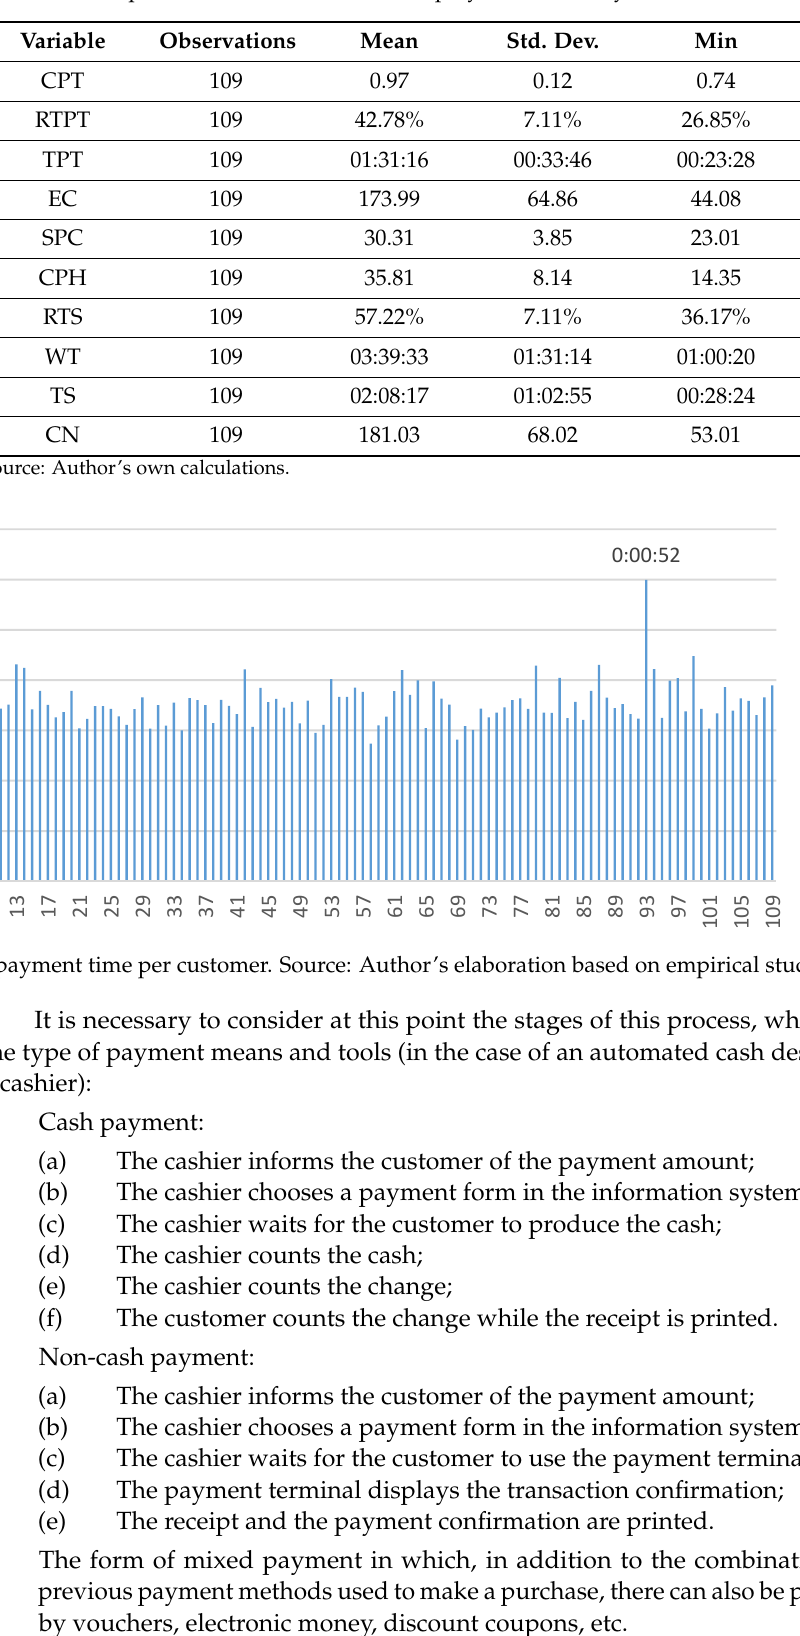
Table 2. Descriptive statistics for variables employed in the analysis.